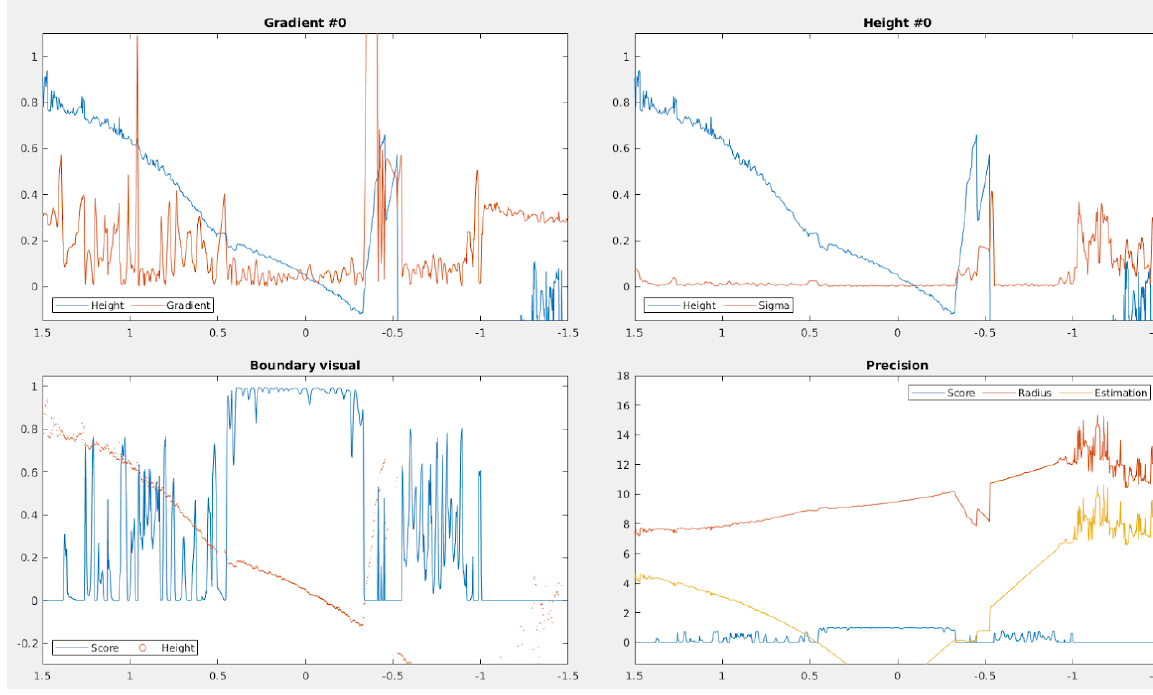
Figure 10. LiDAR ring analysis for road